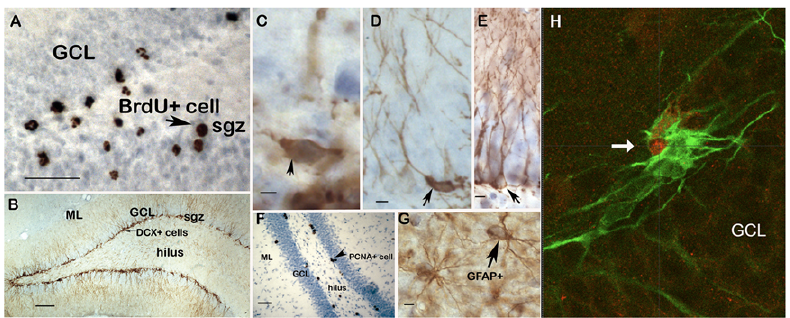
Figure 2. Distribution of BrdU, DCX, PCNA and GFAP positive cells in the rat dentate gyrus. A. BrdU + cells are mainly located in the subgranular zone (SGZ, arrowhead) but can also be found in the hilus. Considerably lower numbers are encountered in the granular cell layer (GCL). Calibration bar: 50 m m. B. Overview of the rat dentate gyrus with vehicle treatment showing strong immunoreactivity of DCX in the SGZ and GCL, with dendrites extending through the GCL into the molecular layer (ML). Calibration bar: 100 m m. C. Arrowhead points to a relatively immature type 1 DCX + cell, without dendrites and/or with horizontally oriented dendrites. Calibration bar: 10 m m. D. Arrowhead points to a type 2 DCX + cell, with dendrites with an oblique orientation, growing into the GCL but not ML. Calibration bar: 10 m m. E. Arrow points to a relatively mature type 3 DCX + cell, characterized by a primary dendrite orientated perpendicularly to the SGZ and with protrusions extending into the ML. Calibration bar: 10 m m. F. Clustered PCNA-labeled cells prevail in the SGZ (arrowhead) but can also be found in the hilar region; these cells are less prevalent within the GCL. Calibration bar: 50 m m. G. GFAP + astrocytes are mainly located in the hilus and ML but not in the GCL. These cells show brown DAB-staining in their processes and cytoplasm whereas the nucleus is devoid of staining (arrow). Calibration bar: 10 m m. H. Double immunofluorescent staining (orthogonal planes) of a DCX-Ki67 double immunopositive cell in the SGZ of a 21ds CORT + d18 MIF treated animal, demonstrating that at least a subset of the DCX + cells can re-engage in cell cycle. Arrow indicates red Ki-67 signal in the nucleus of a green DCX + cell. 40 6 magnification; GCL: granule cell layer of the hippocampal dentate gyrus.